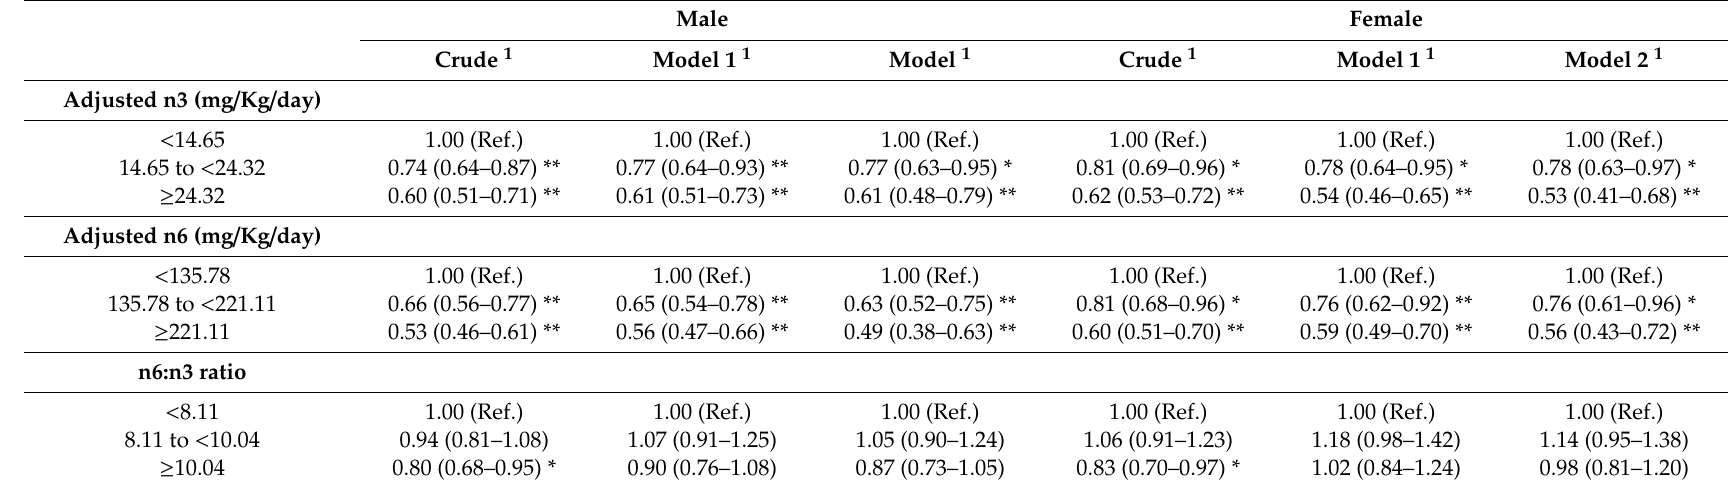
Table 3. Weighted odds ratios (95% confidence intervals) of hypertension across tertiles of adjusted dietary n3, n6 fatty acid intake and n6:n3 ratio, stratified by gender, NHANES 2007–2014 ( N =